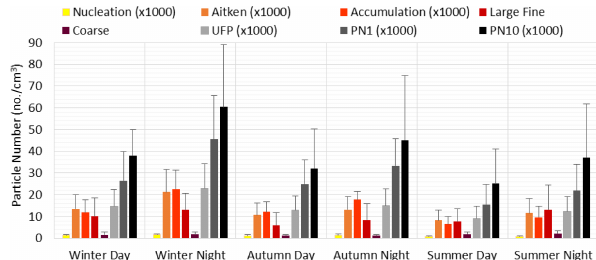
Figure 5. The hourly average of day- and nighttime particle num- bers for all modes from the wide-range particle sizes derived from the merged data. UFP = Nucleation + Aitken, PN 1 = UFP + Accumulation, PN 10 = PN 1 + Large Fine + Coarse.